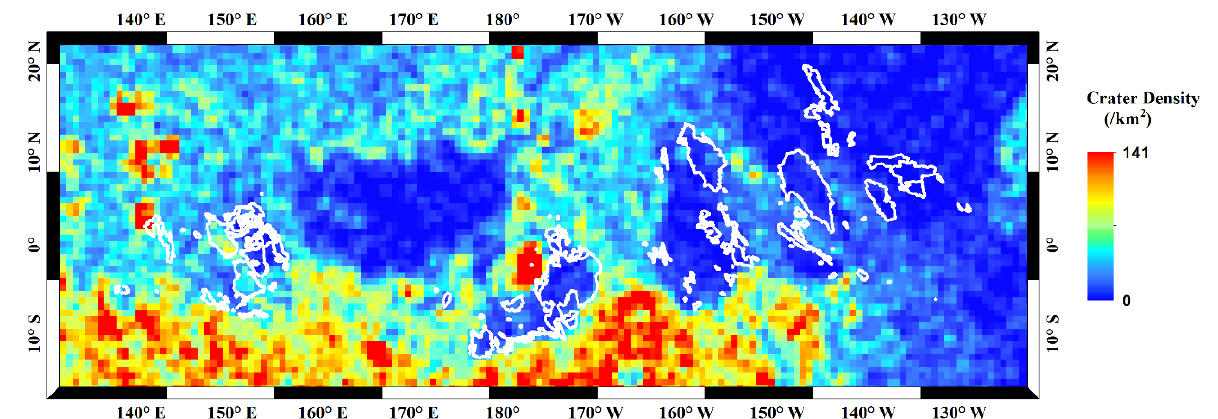
Figure 9. The density of impact craters larger than 1 km in diameter in the MFF. It can be seen that the craters in yardangs’ area are indeed more sparsely distributed than in the other areas. The impact craters are from reference [44].